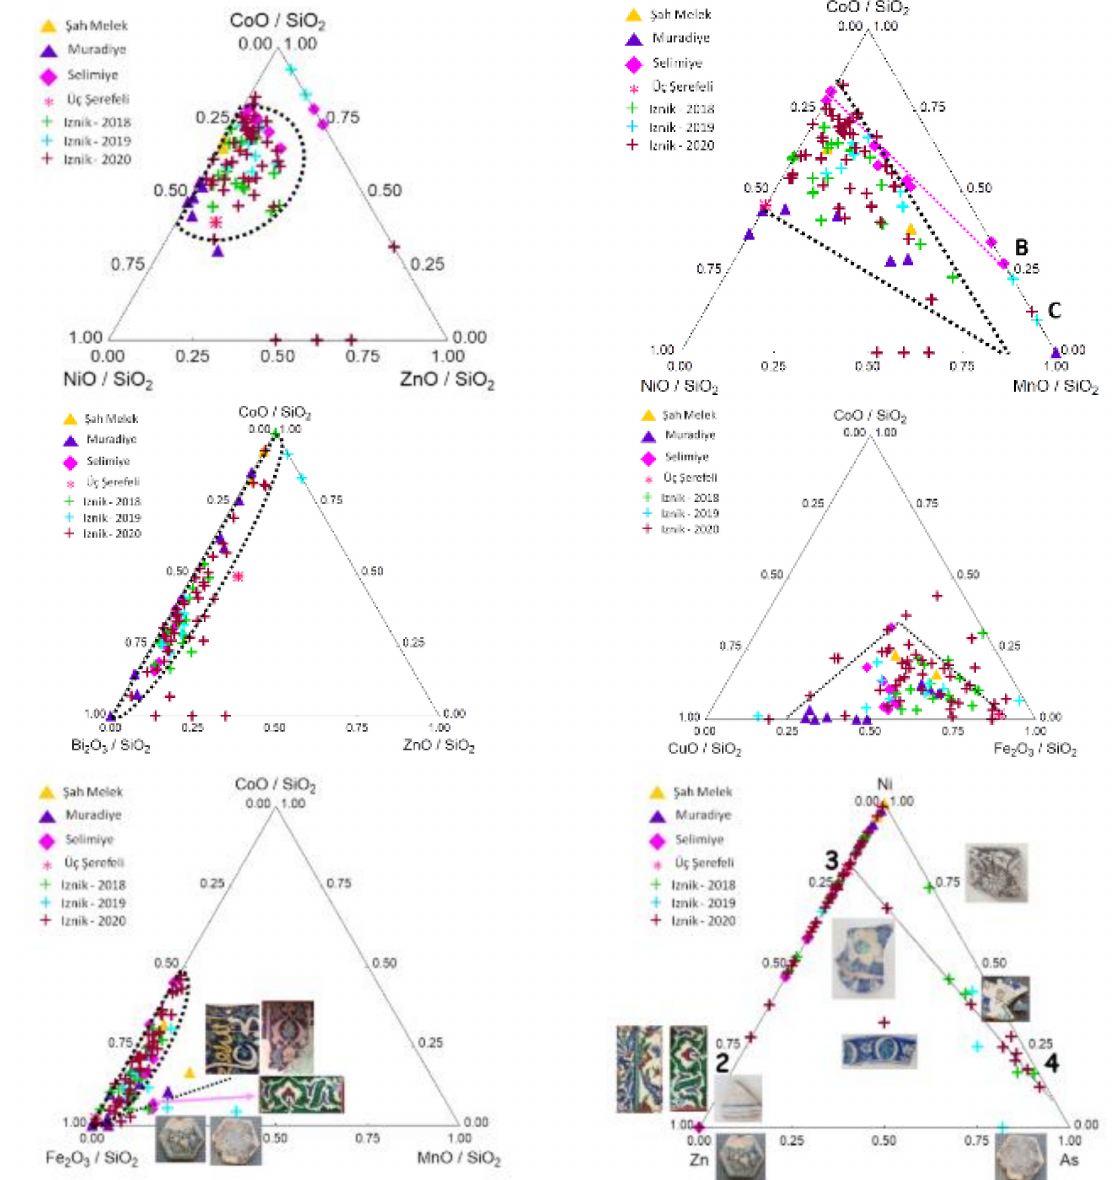
Figure 7. Comparison of the intrinsic variability measured on the 15th–16th-centuries Iznik sherds unearthed at the Iznik tile kilns excavation (green, blue, and claret red plus) and tiles from the mosques in Edirne (¸Sah Melek Pa¸sa (yellow triangle), Muradiye (blue triangle), Selimiye (pink lozenge), and Üç ¸Serefeli (cyclamen asterisk) mosques). Data are obtained from measurements used in references [22] and [23]. Visual guidelines are drawn; numbers 3 and 4 refer to the Gratuze et al.’ groups (see Figure 4 and Table 1). Dividing by SiO 2 allows for the elimination of the errors occurring due to the variable setting of the handheld pXRF